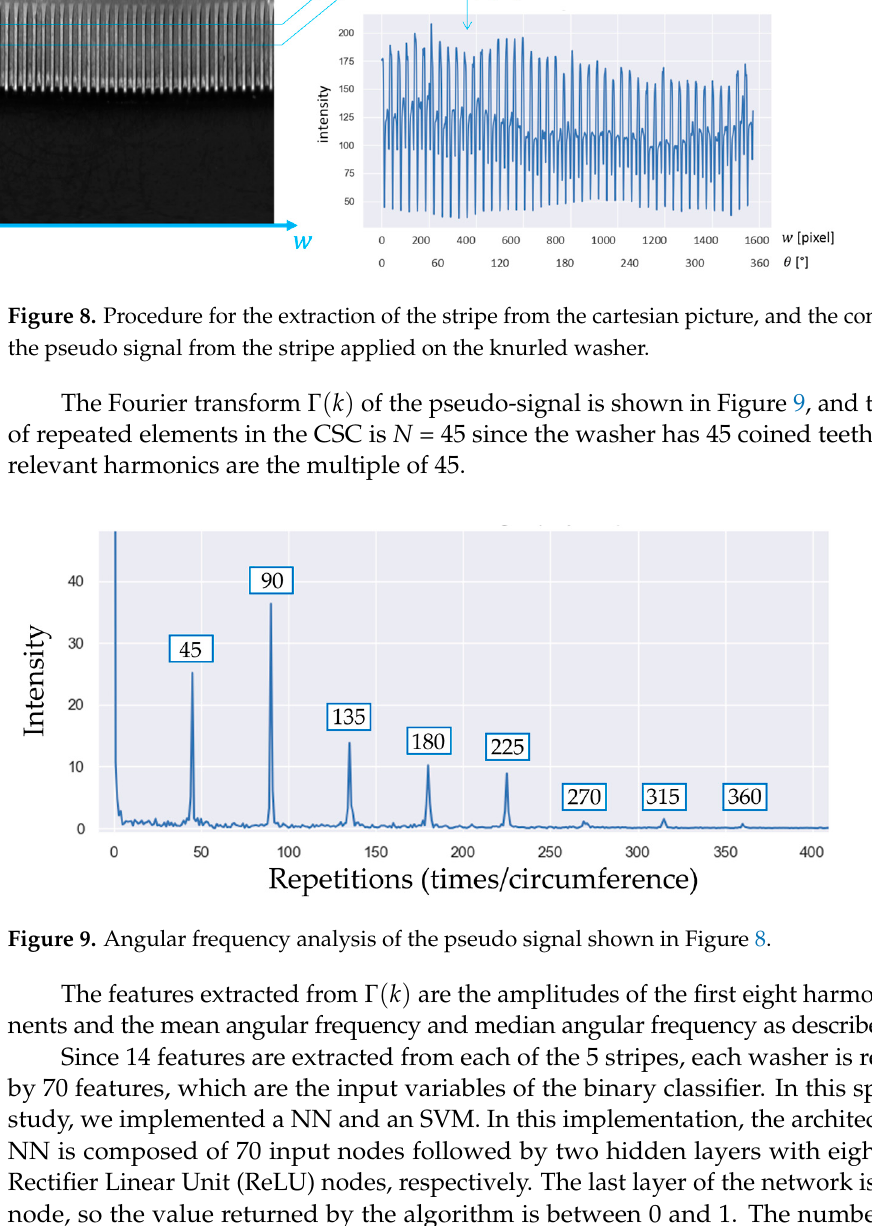
8 of 19 Figure 7. Knurled washer: case study component.